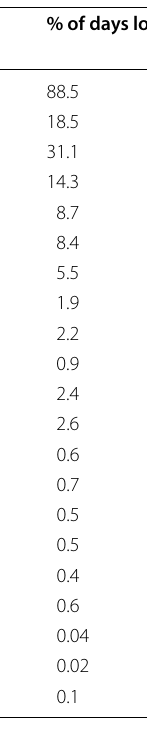
Table 2 Absolute numbers, proportions, IRs, proportions on overall time loss according to injury location